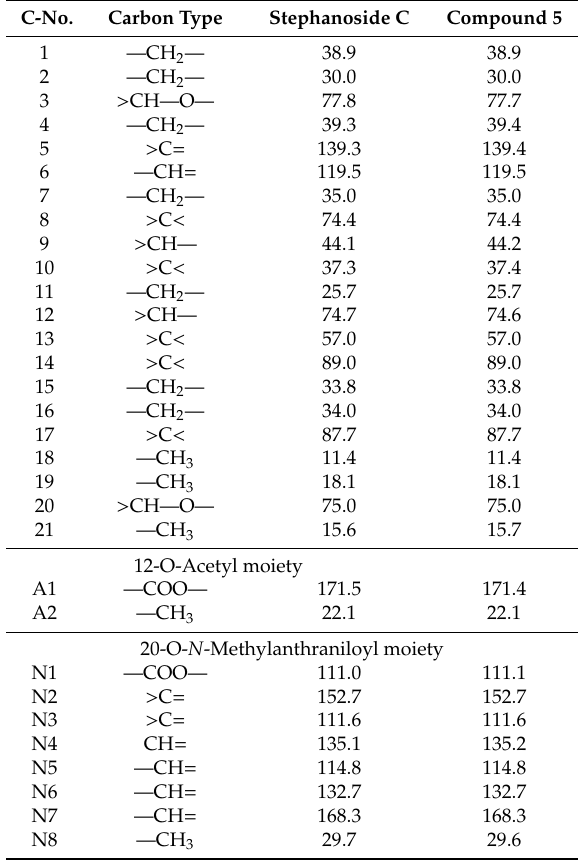
Table 3. The 13 C NMR chemical shifts of stephanoside C and compound 5 ( δ : ppm).